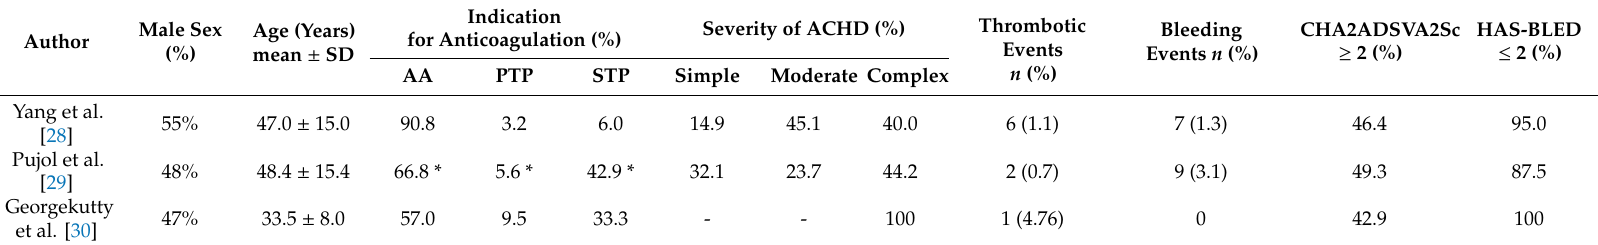
Table 4. Descriptive characteristics of included studies.